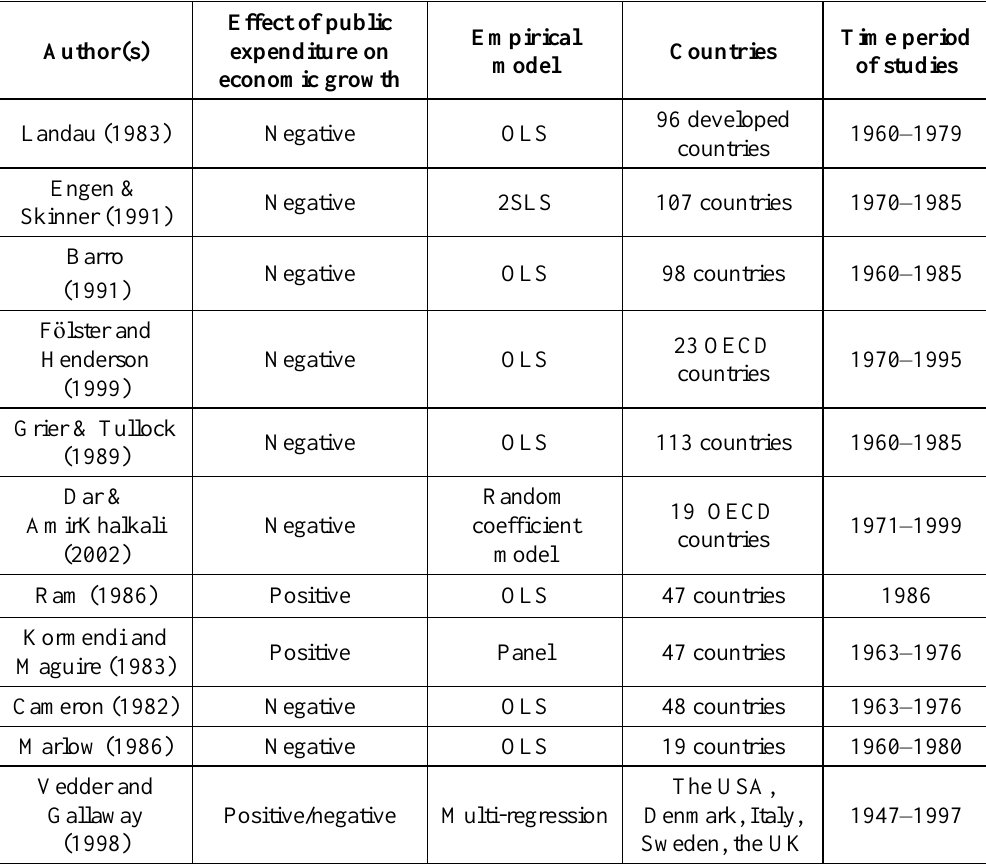
Table 1. Effect of Public Expenditure on Economic